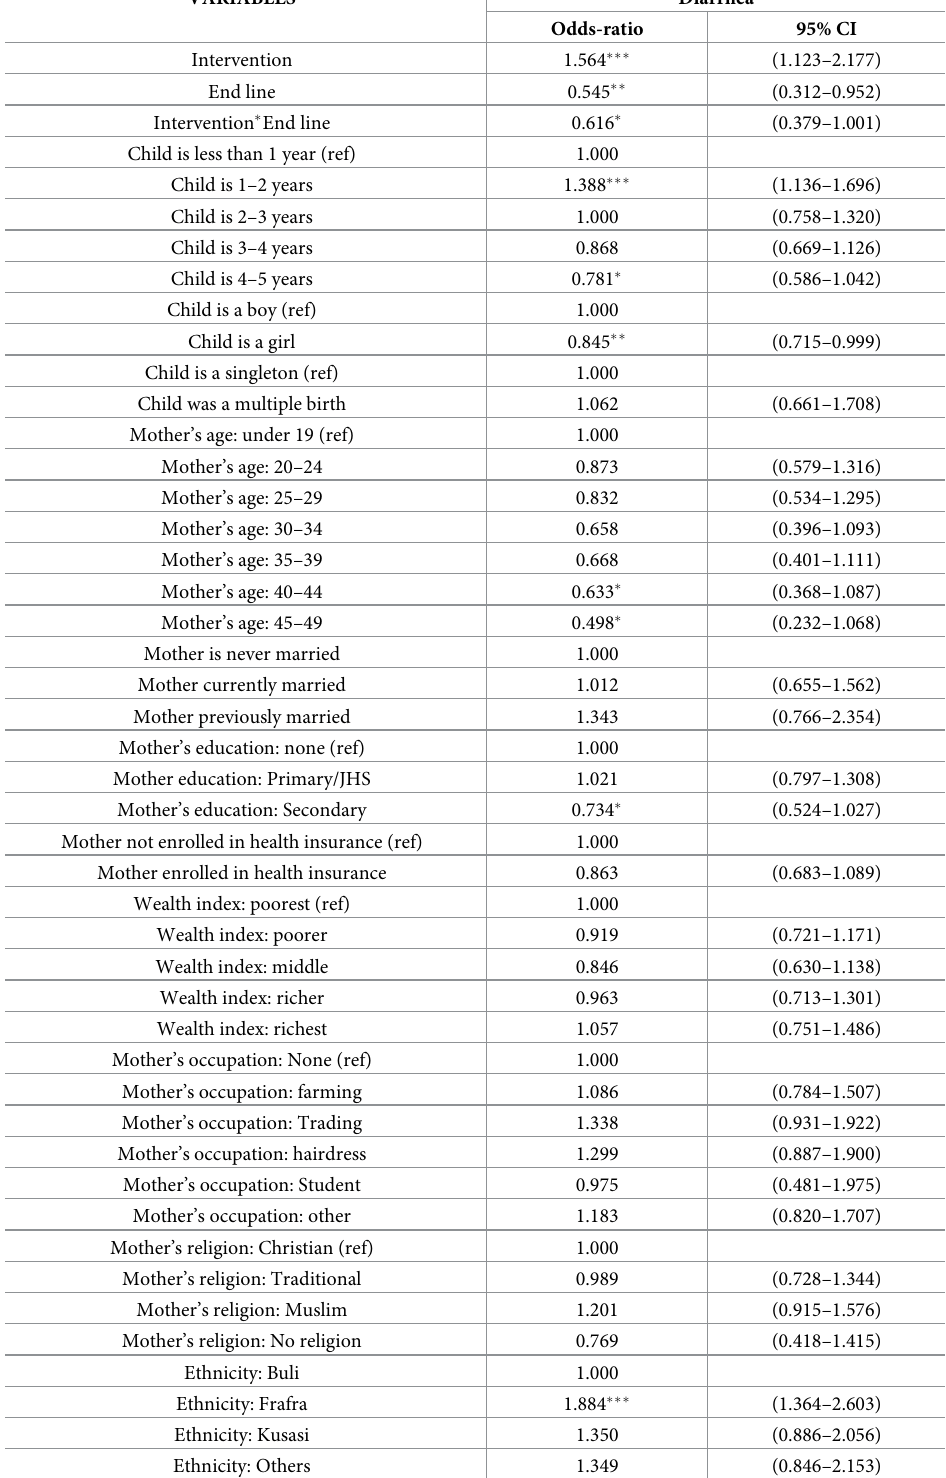
Table 2. The estimated effect of GEHIP on health system childhood morbidity